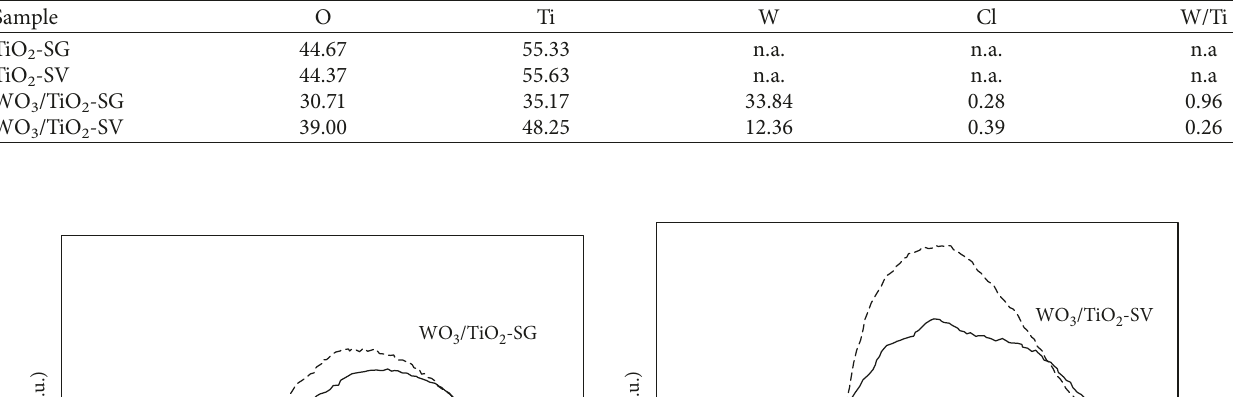
3 /TiO 2 -SG and (b) WO 3 /TiO 2 -SV catalyst.